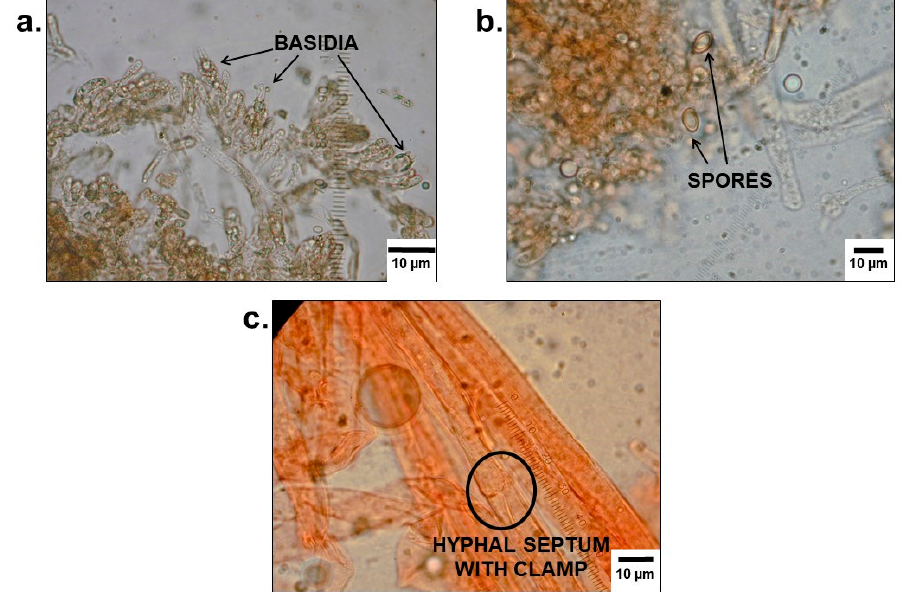
(honey fungi) and ( b ) Paxillus involutus . Diagnostics 2019 , 9 , x FOR PEER REVIEW